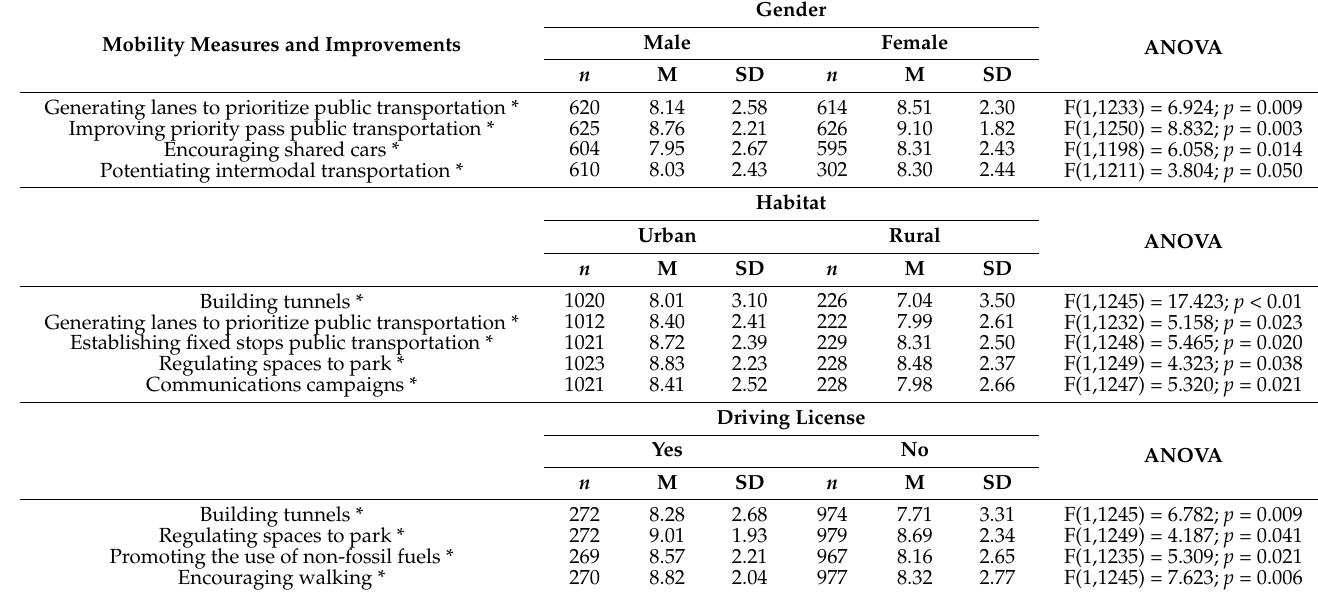
Figure 4. Assessment of future mobility measures by Dominican citizens. Table 2. Differences in the assessment of mobility measures according to citizens’